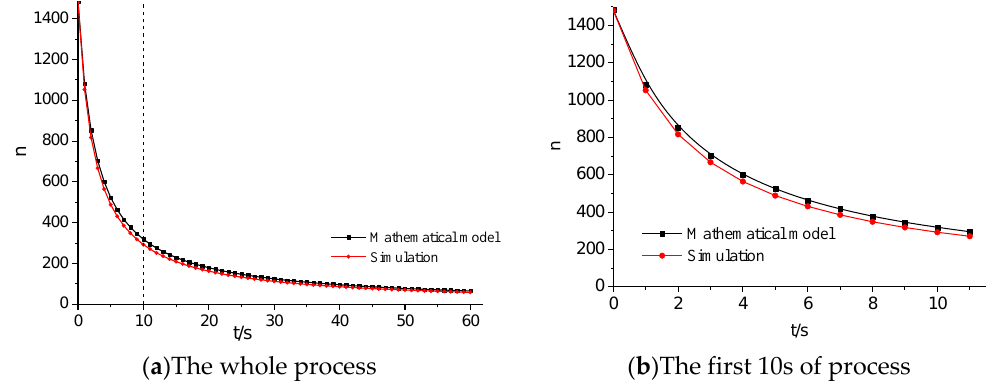
Figure 9. Chart of simulation test and mathematical model calculation